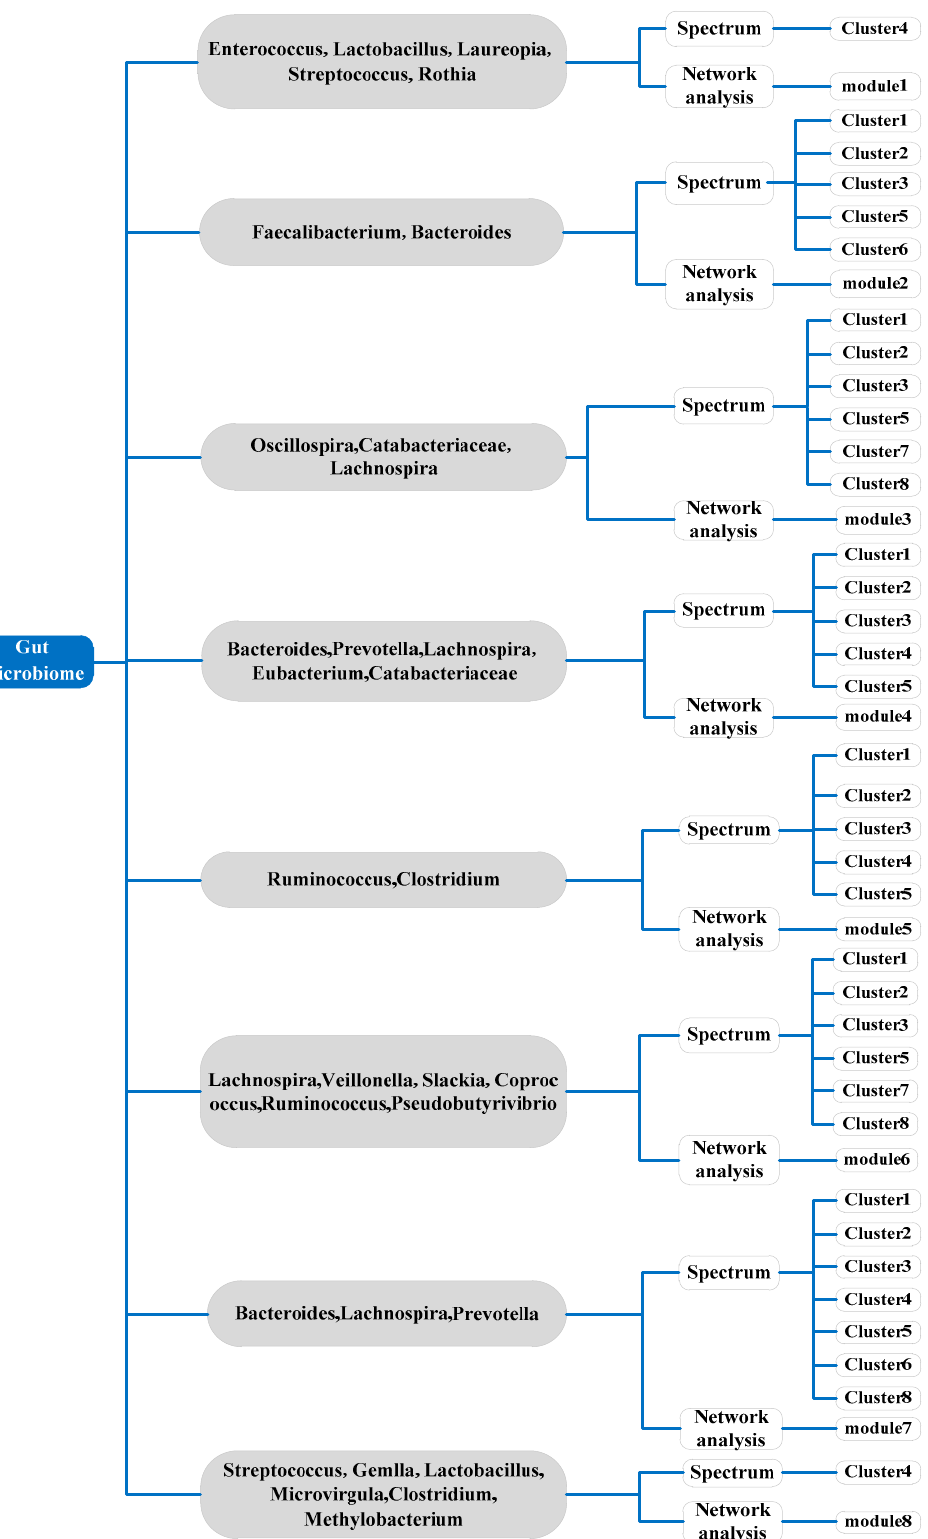
Figure 6. Correspondence between GMPR+Spectrum and network analysis of core flora in all samples group.